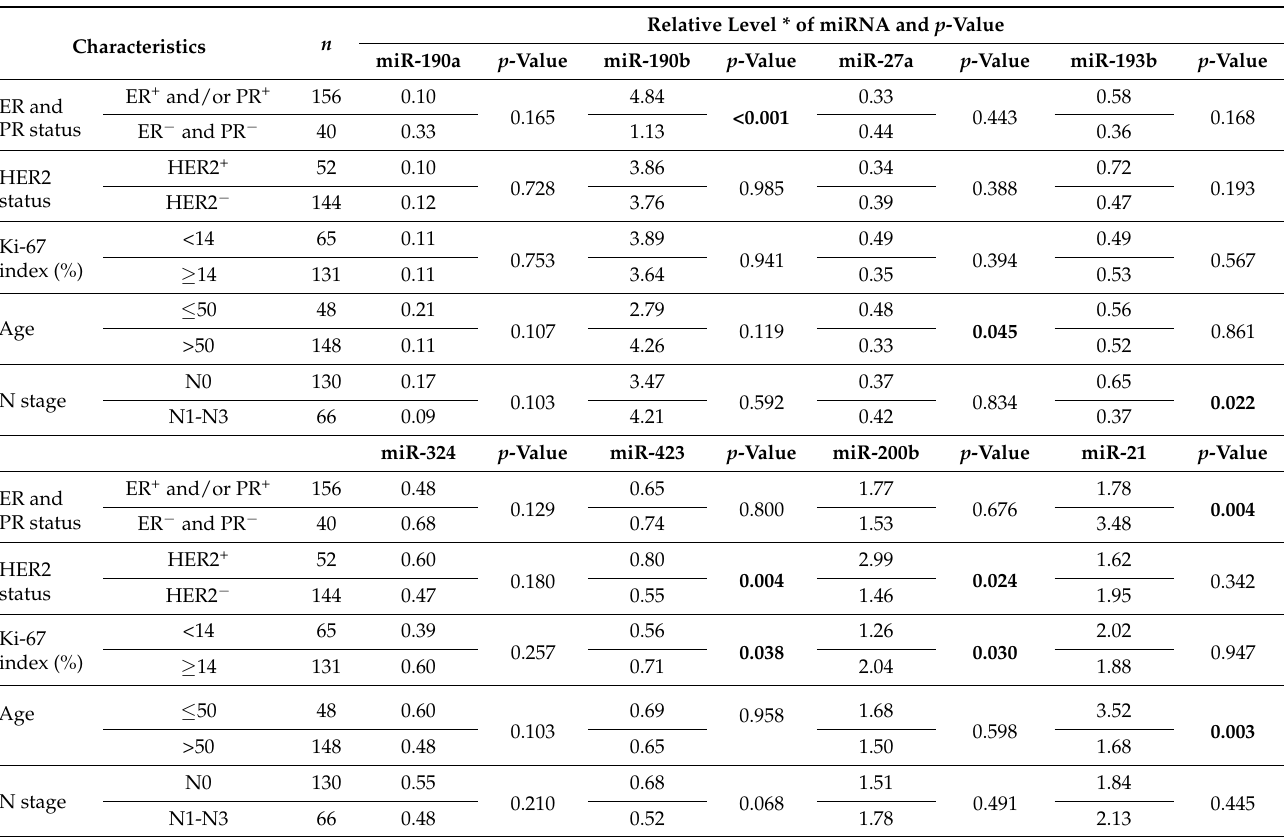
Table 4. Associations between the amounts of miR-190a, miR-190b, miR-27a, miR-193b, miR-324, miR-423, miR-200b, or miR-21 in tissue samples from BC patients and ER, PR, HER2 status, Ki-67 index, age, or LN